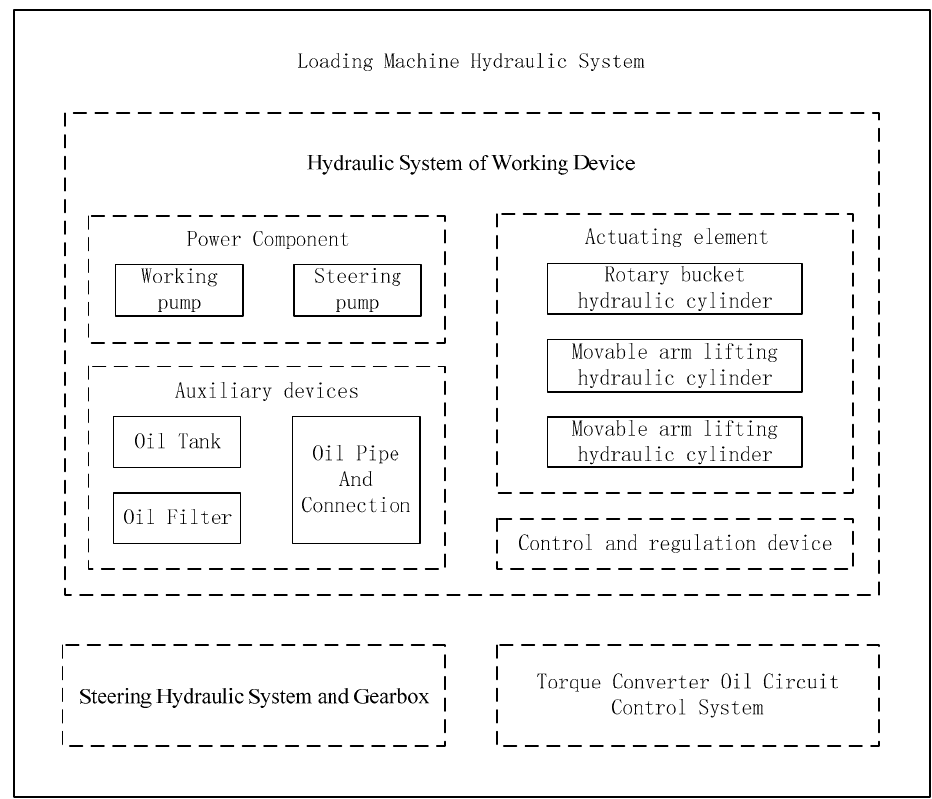
Figure 2. Theloader’s hydraulic-system diagram.